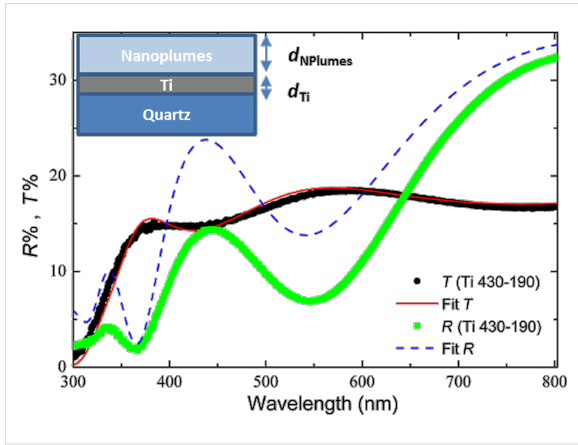
Figure 5: Fitting of the transmittance and reflectance spectra of Ti (430-190).